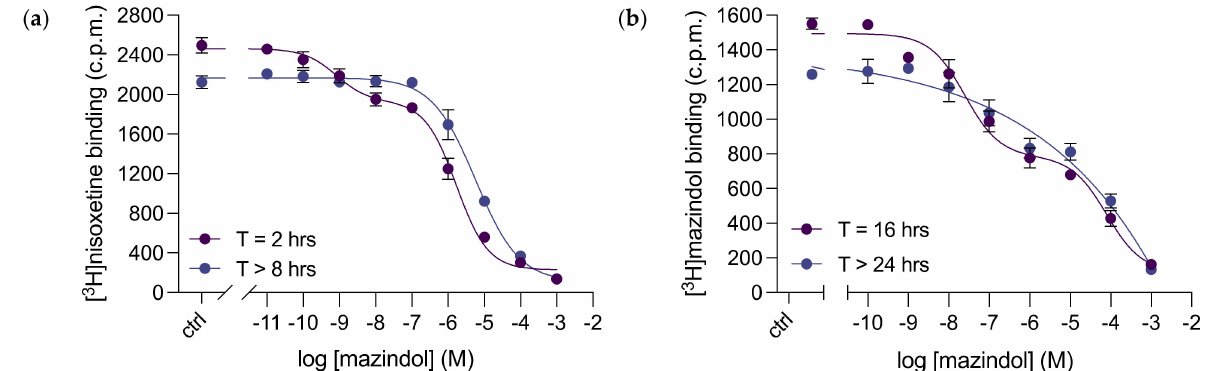
Figure 6. Mazindol binding to purified dDAT, assessed by radioligand binding. ( a ) Representative data of competitive inhibition of [ 3 H]nisoxetine binding to purified dDAT by unlabelled mazindol. Data were collected after a 2 h incubation at RT or after a further incubation overnight at 4 ◦ C, and fitted as two-site competition binding or as a sigmoidal dose–response curve (variable slope), respectively. K i values for mazindol of 0.2 nM and 402 nM were estimated for the two binding populations in the displayed biphasic dataset for T = 2 h. Data points represent mean ± SEM performed in triplicates. The displayed monophasic binding curve of T > 8 h is representative data of n = 3 from 2 independent dDAT-His 8 purifications, performed in triplicates. This acquired K i for mazindol was 2.8 [2.2; 3.7] µ M. Data points represent mean ± SEM. ( b ) Representative data of homologous competitive [ 3 H]mazindol binding to purified dDAT. Data were collected after 8 h incubation at RT or after over 24 h incubation at 4 ◦ C, and fitted as two-site competition binding or as a sigmoidal dose–response curve (variable slope), respectively. IC 50 values for mazindol of 25 nM and 79 µ M were estimated for the two binding populations in the displayed biphasic dataset for T = 16 h. Data points represent mean ± SEM performed in triplicates. The displayed monophasic binding curve of T > 24 h is representative data of n = 3 from 2 independent dDAT-His 8 purifications, performed in triplicates. This acquired K d for mazindol was 13 [5; 34] µ M. Data points